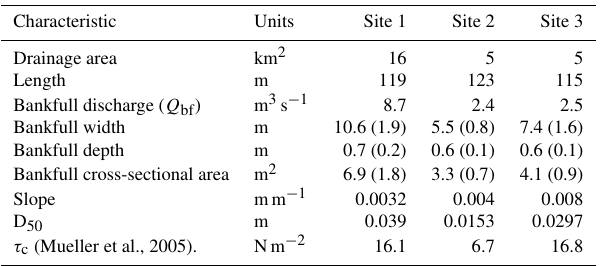
Table 1. Characteristics of the three study sites. Values in parenthe- sis correspond to the standard